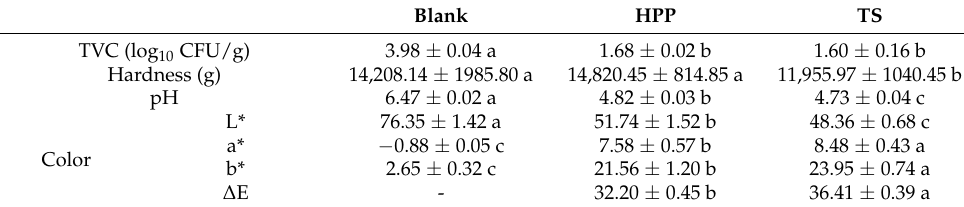
Table 2. Quality properties of HPP and TS marinated lotus root slices.